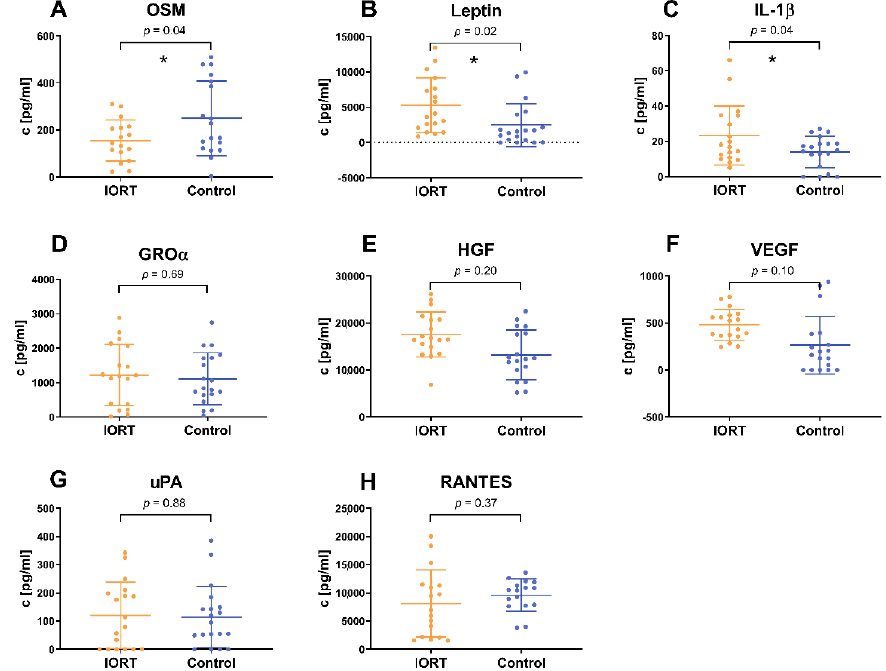
Figure 3. Cytokine concentrations tested in the individual WF samples by ELISA for OSM ( A ), leptin ( B ), IL-1 β ( C ), GRO α ( D ), HGF ( E ), VEGF ( F ), uPA ( G ) and RANTES ( H ). N = 18 IORT (yellow) and 18 control (blue), each n = 3. Indicated values: mean ± standard deviation, statistical analysis by double sided t -test, * p <